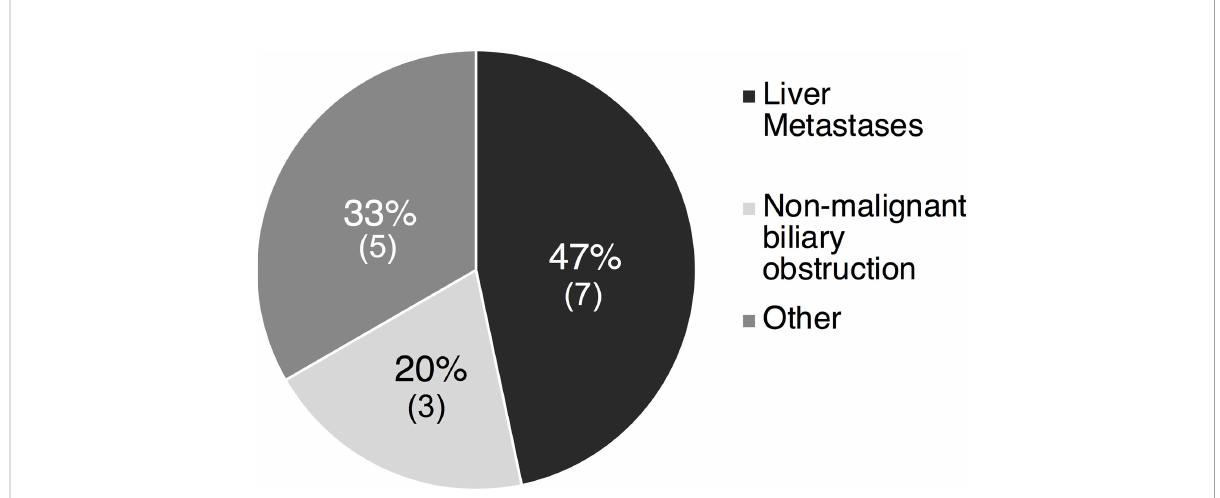
FIGURE 3 Etiology of liver injury in 15 non-DILI liver cases of the 15 patients with a causality score of 4-5 indicating possible/unlikely DILI, 7 (47%) had liver injury attributed to the presence of liver metastases and 3 (20%) due to non-malignant biliary obstruction. Other causes in 5 (33%) included Gilbert ’ s (1), bone metastases (1), lung abscess (1) and unknown causes (2). DILI, drug induced liver